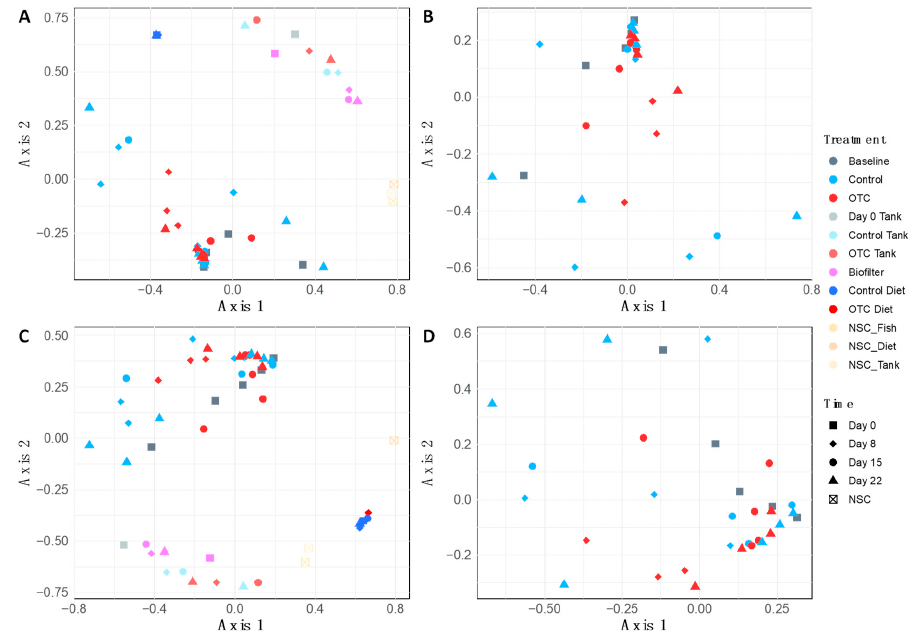
Figure 3. Non ‐ multidimensional scaling of ThetaYC ( A , B ) and Bray − Curtis ( C , D ) distances. Distances illustrate differences in the microbiome community membership and composition of samples across time and exposure to oxytetracycline (OTC). Distances were generated for the complete dataset including aquarium biofilter, tank biofilm, diet, and negative sequencing control (NSC) samples ( A , C ), and within the distal gut of Nile tilapia alone ( B , D ).